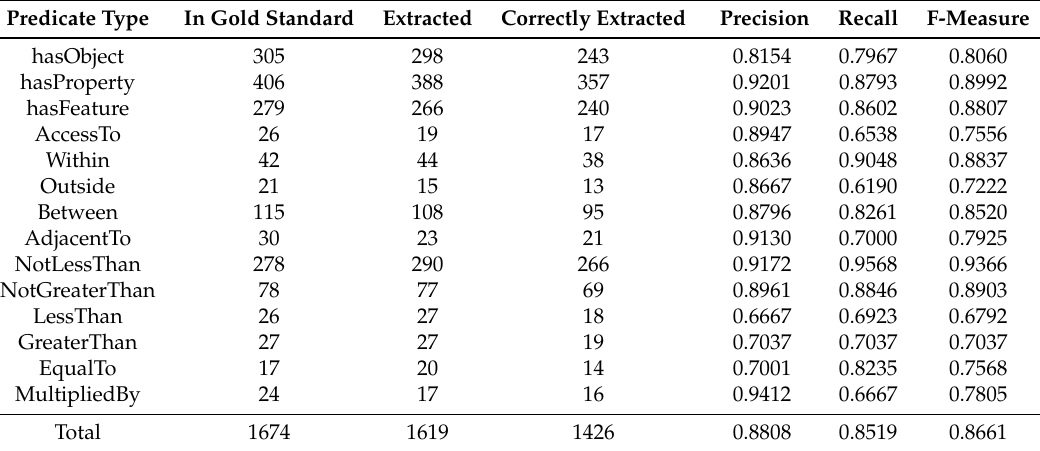
Table 4. Precision, recall, and F-measure results obtained through model testing.